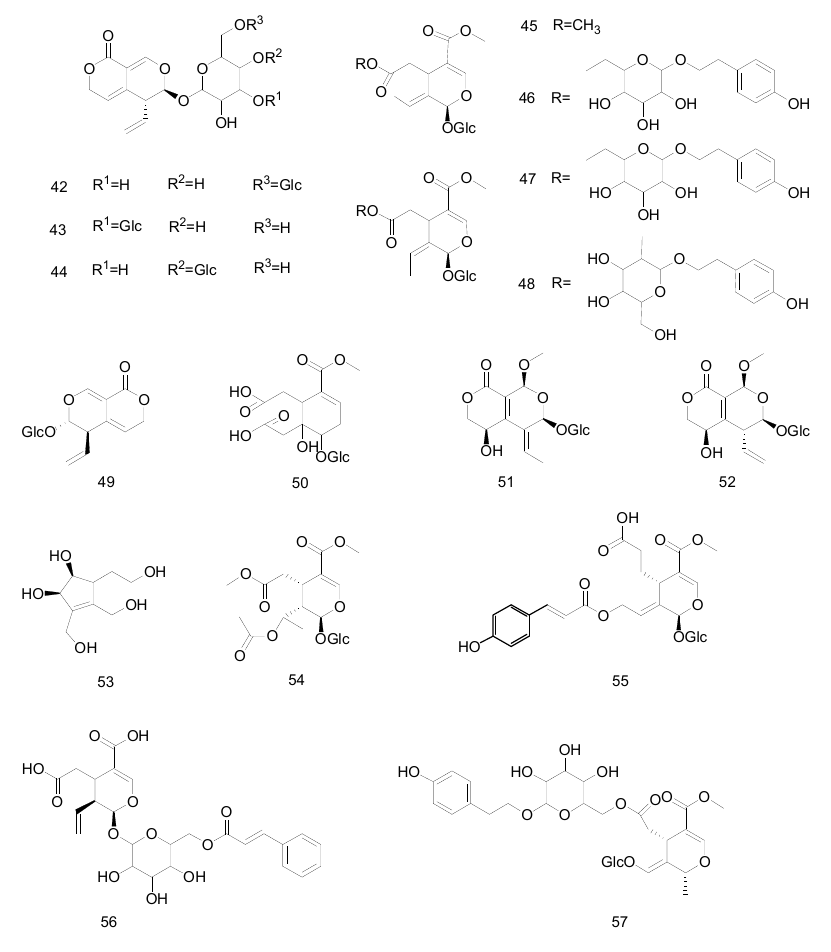
Figure 3. Chemical structures of secoiridoids.